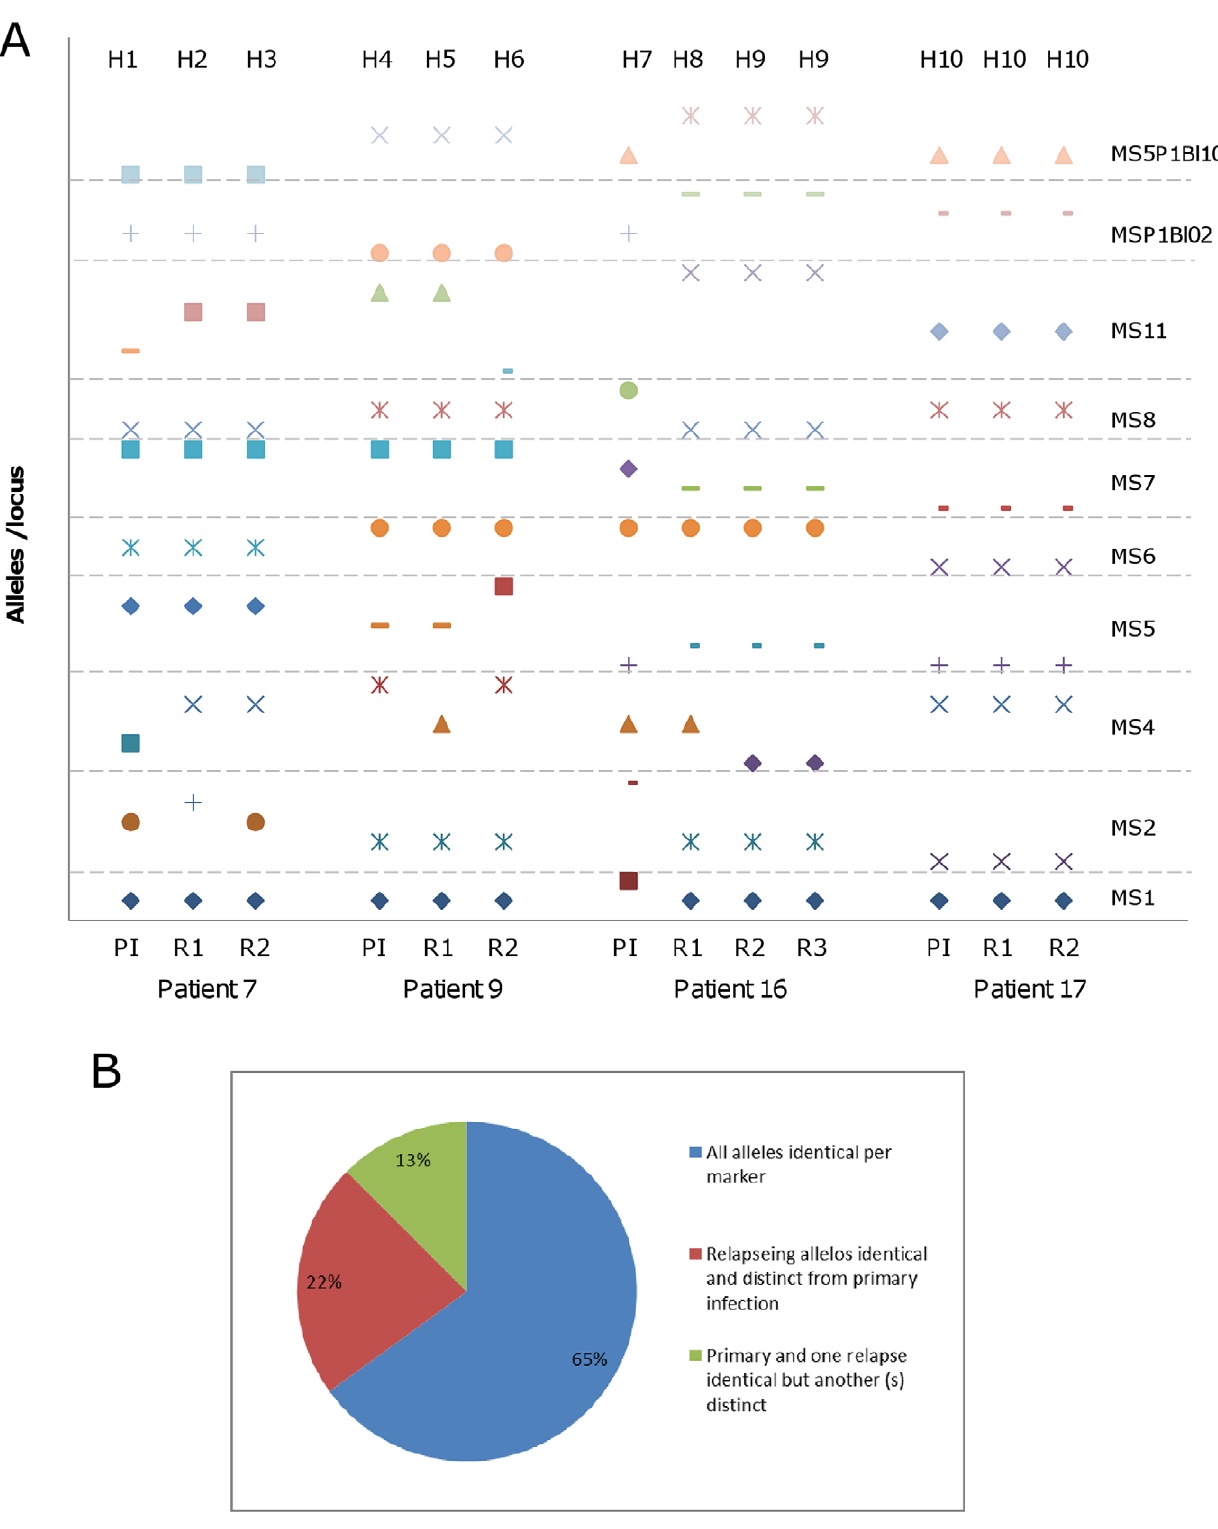
PLOS ONE | www.plosone.org